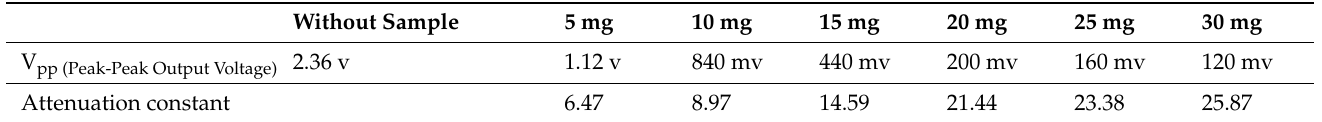
Table 1. Attenuation constant for wheat flours for different weights of